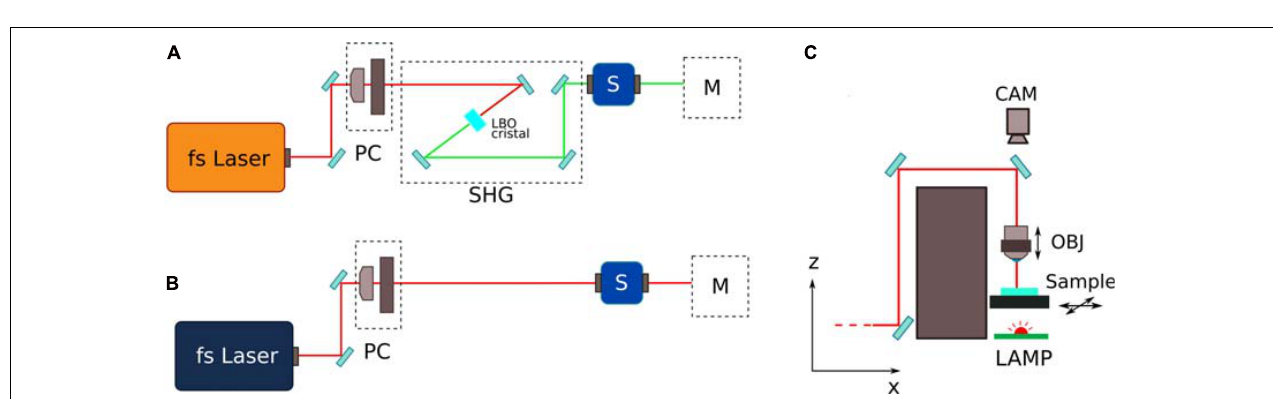
FIGURE 1 | Scheme of multilayer device fabrication procedure. (A) fs-laser irradiation of reservoirs inside fused silica layer; (B) selective etching of the irradiated structures in HF solution; (C) resist spin-coating on the glass coverslip; (D) multilayer structure assembling; (E) micro-constrictions fabrication with 2PP; (F) device sealing with UV illumination and masking; (G) unpolymerized resist removal by solvent bath; (H) final device assembled.